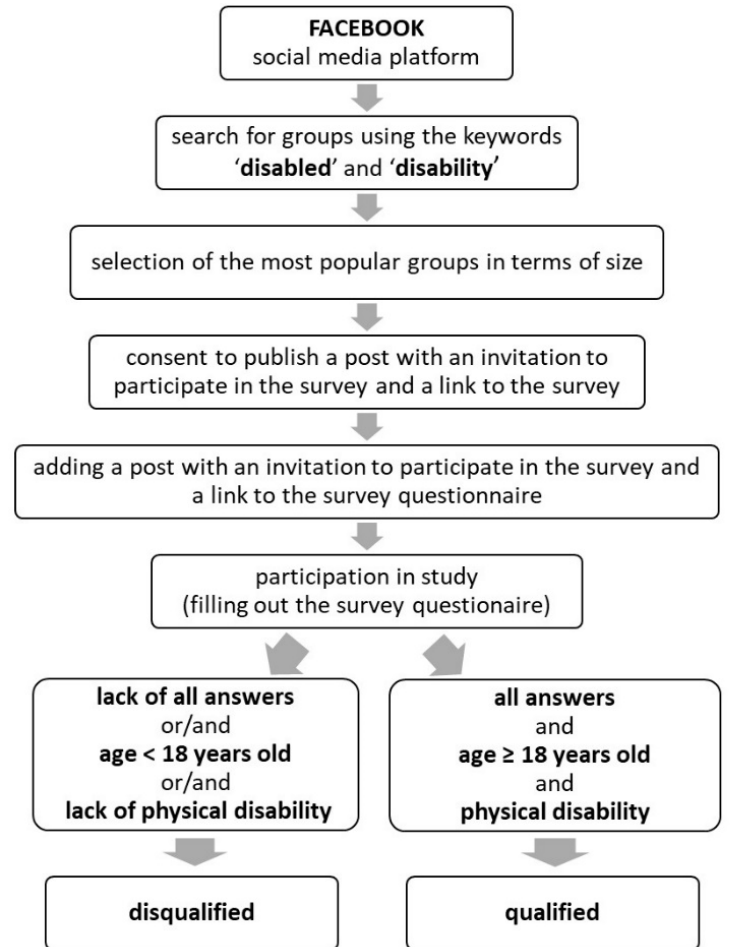
Figure 1. Infographic that describes the organizational structure of the survey.